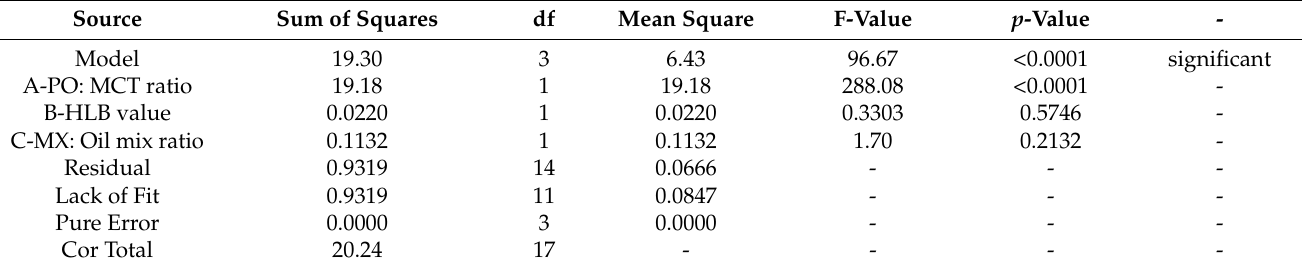
Table 8. ANOVA data for ulcer index in various experimental